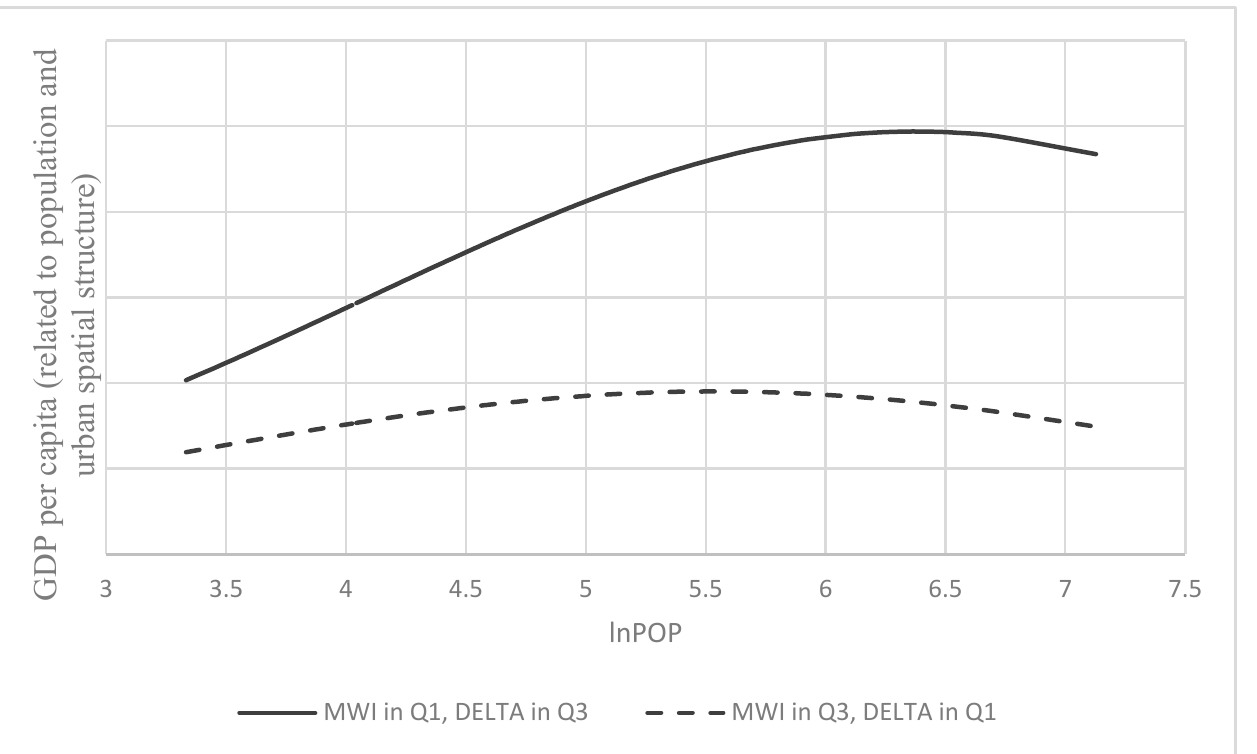
Figure 6. The inverted U shape in the relationship between size and economic performance for cities with different spatial structures.